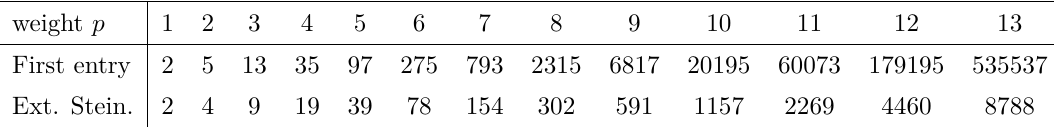
Table 1 . The dimension of the space of symbols with physical branch cuts in the DS limit (first line), that additionally obey the extended Steinmann relations (second